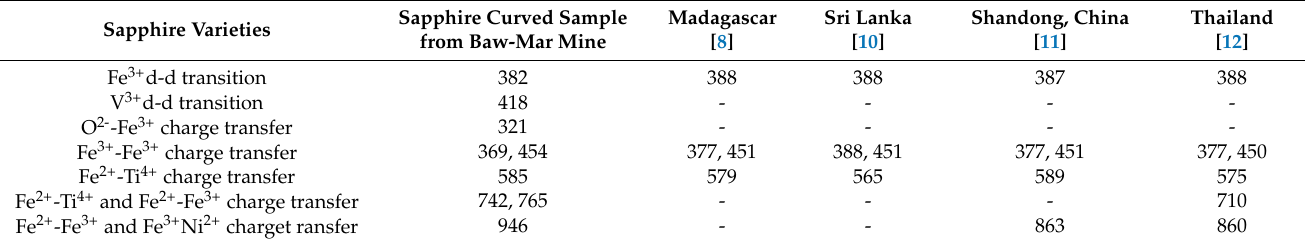
Table 2. UV-Vis absorption peak frequency and attributes of sapphires in this study and other locations (nm). Sapphire